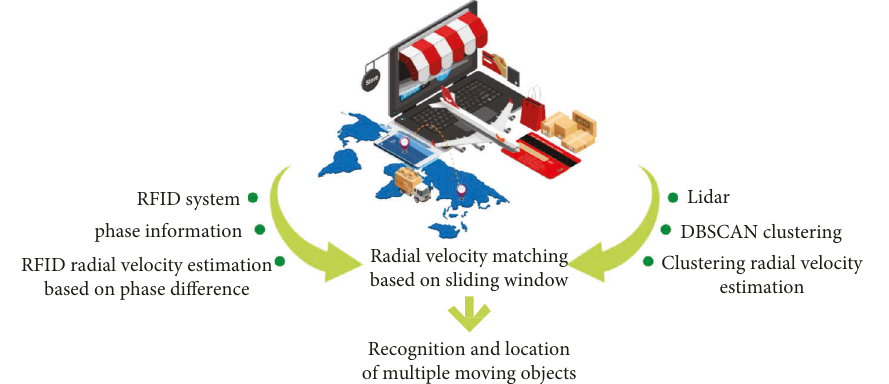
Figure 1: Block diagram of a single dynamic target recognition and positioning system. Table 2: Influence of antenna settings on experimental